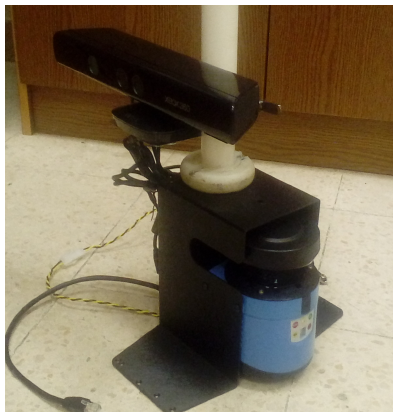
Figure 17. A configuration where the views of the sensors are in different